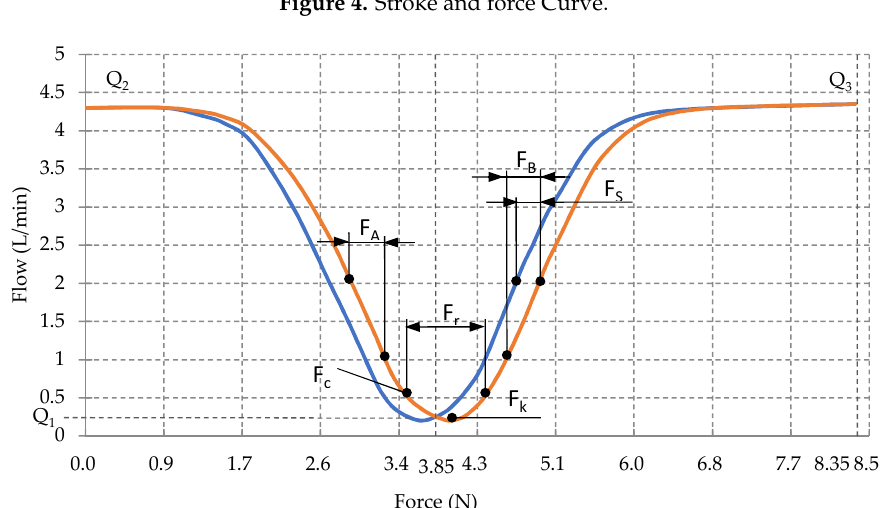
Figure 5. Force and flow characteristic curve. Table 2. Test description and test parameters.